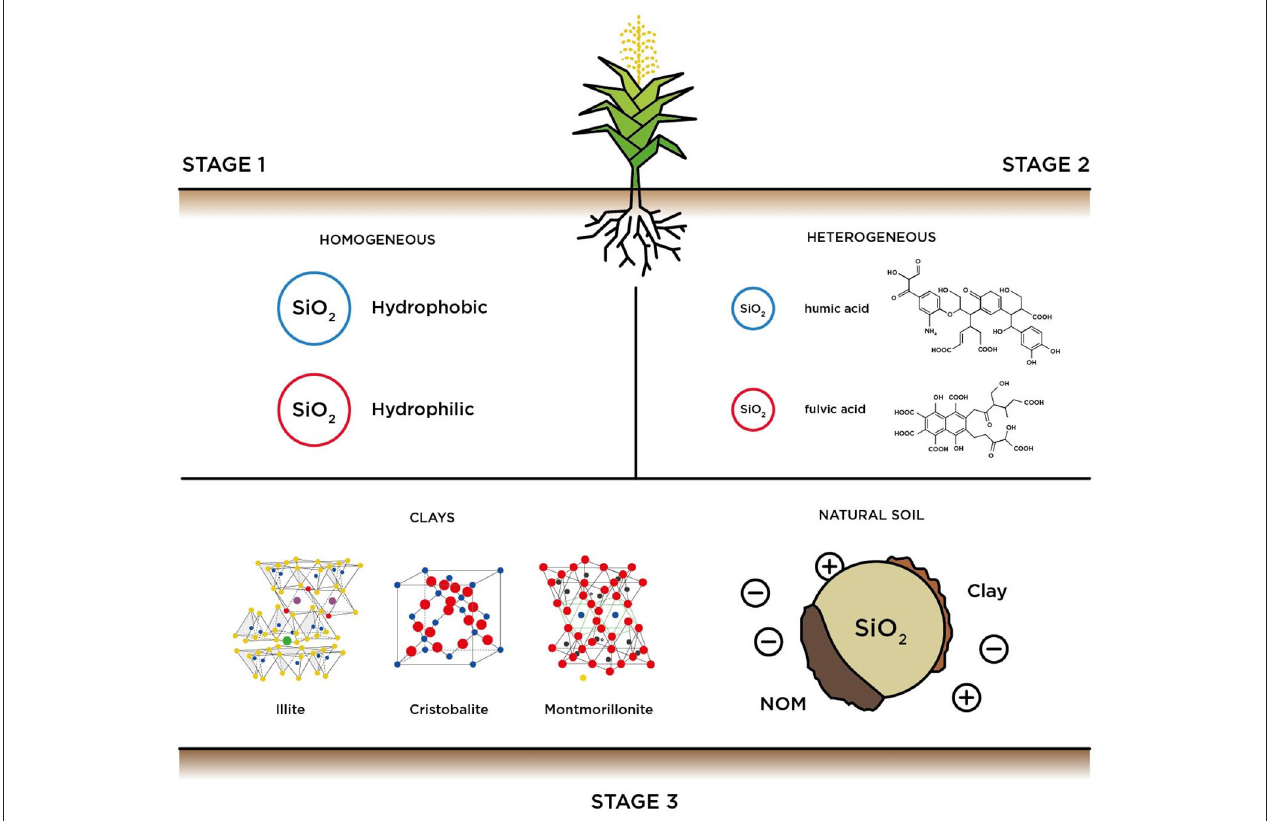
FIGURE 1 | Description of the experimental stages used to assess the adsorption of bypiryridine